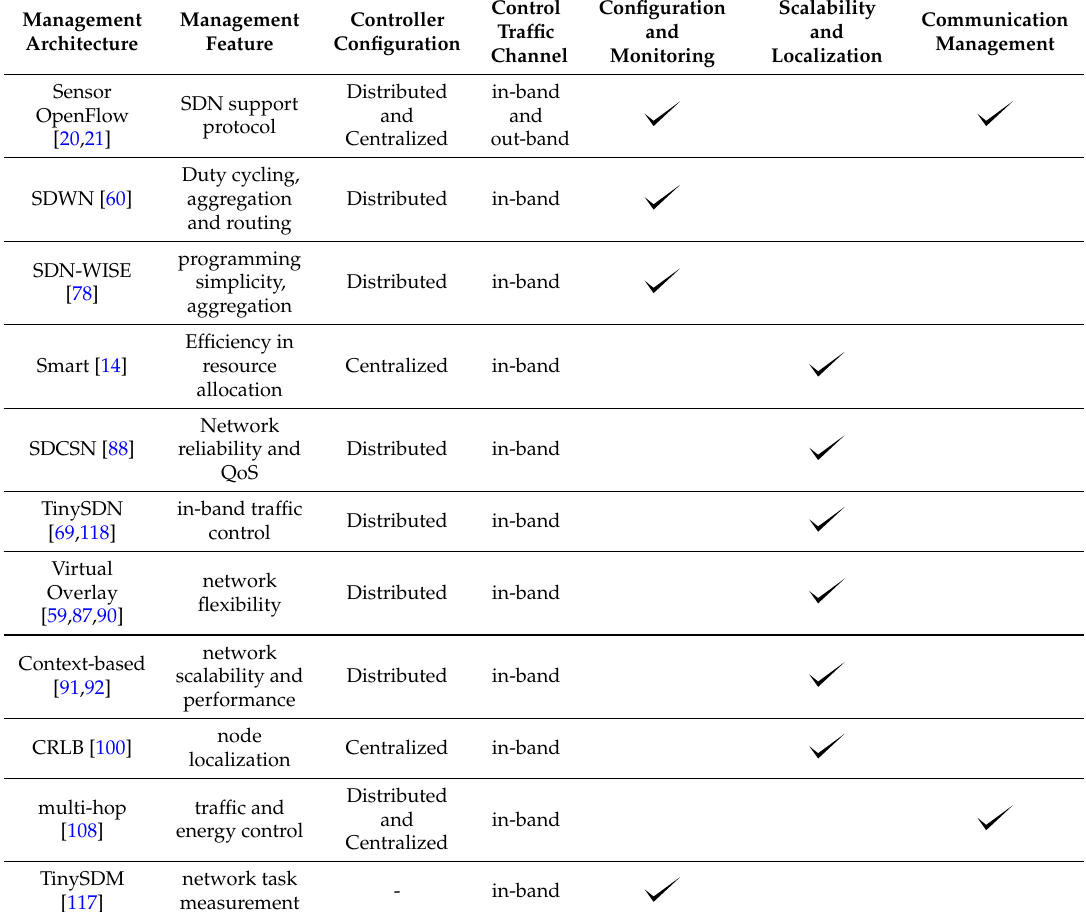
Table 2. SDN-based network and topology management